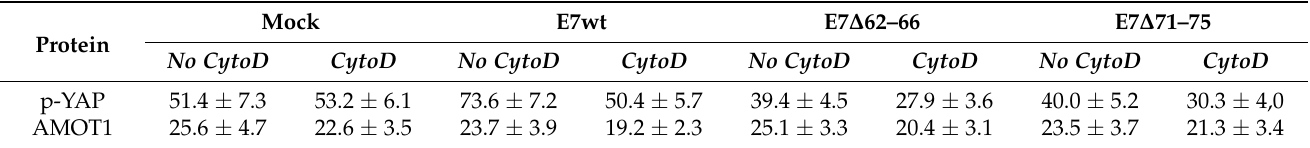
Table 1. Quantitative cytofluorimetric analyses, restricted to efficiently transfected cells (pAmCyan-positive cells), of AMOT expression level and YAP phosphorylation state in the presence or absence of CytoD. Data are reported as mean ± SD of the median fluorescence intensity values obtained in three independent